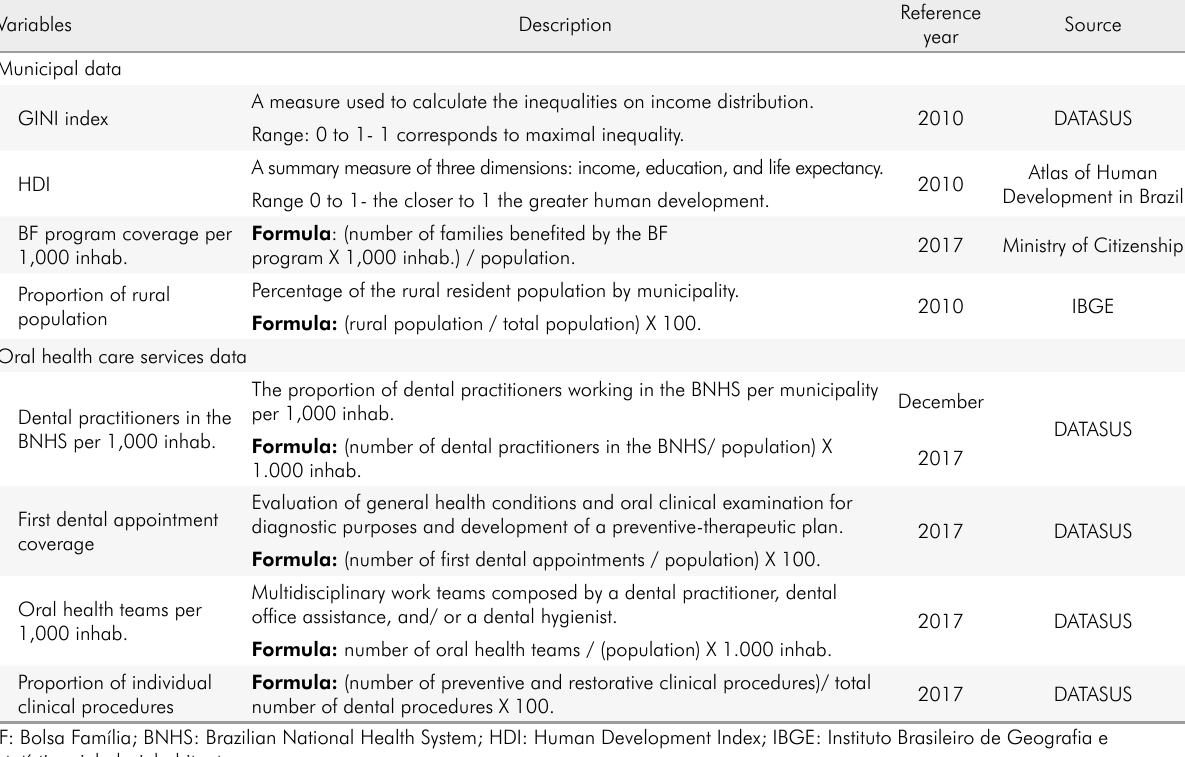
Table 1. Description of the independent